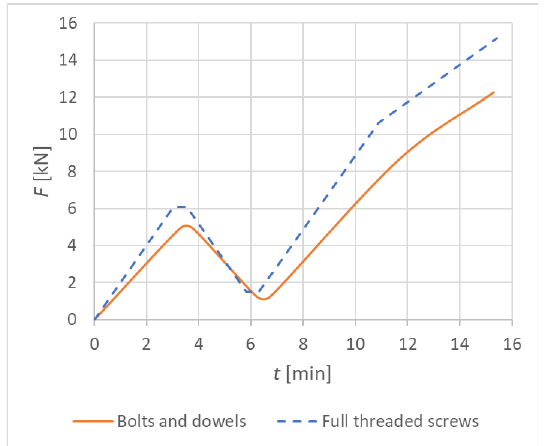
Figure 4. Course of the loading; see Johanides 2022 [43].